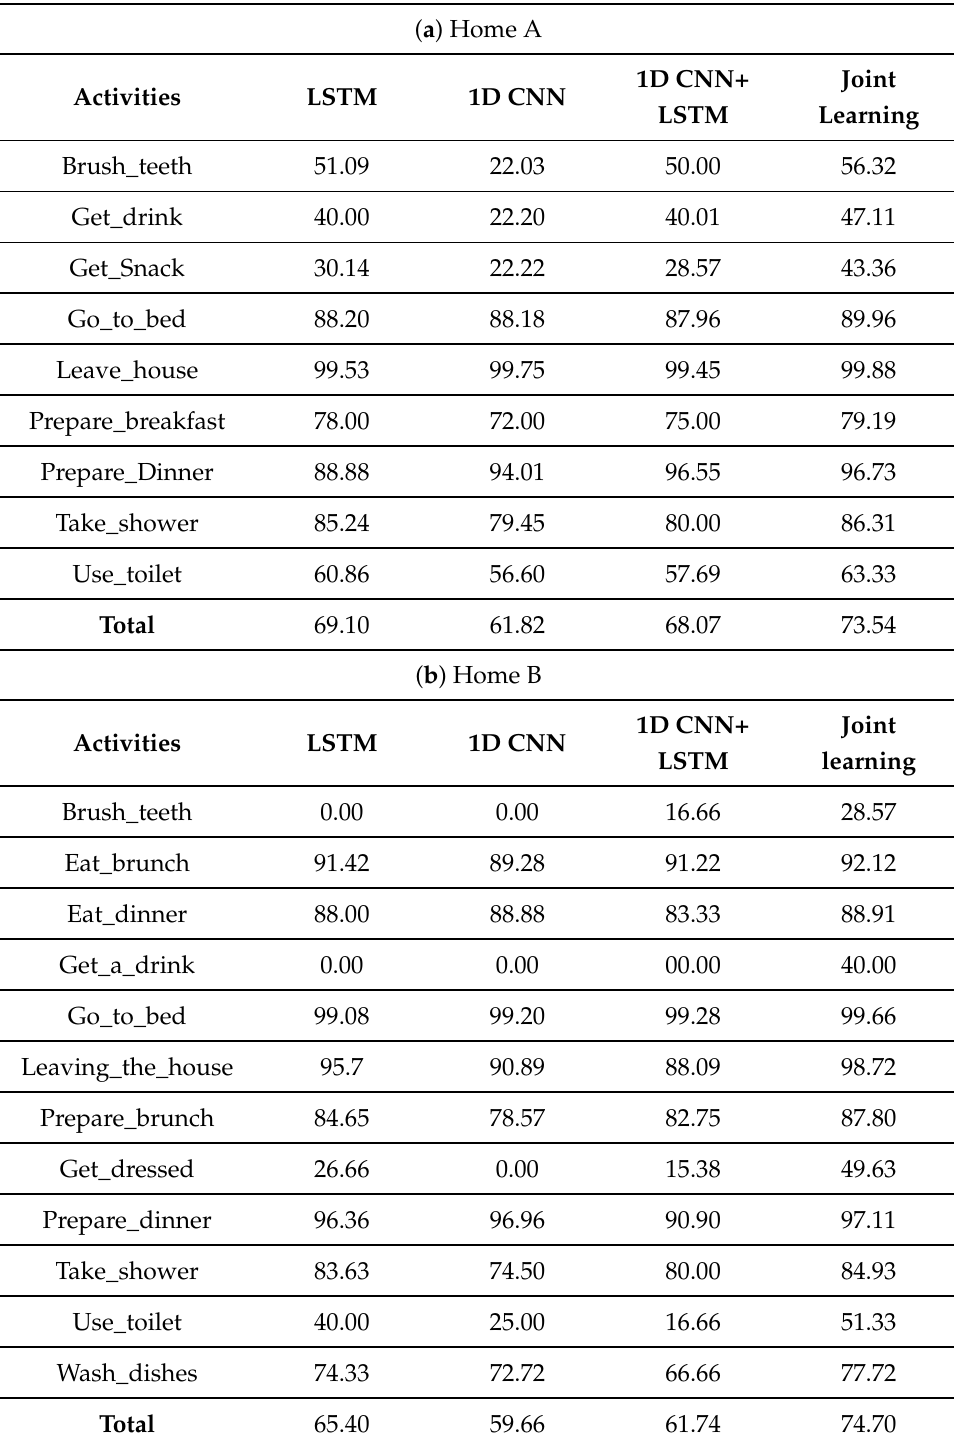
Table 5. F1-score results of Kasteren Smart home